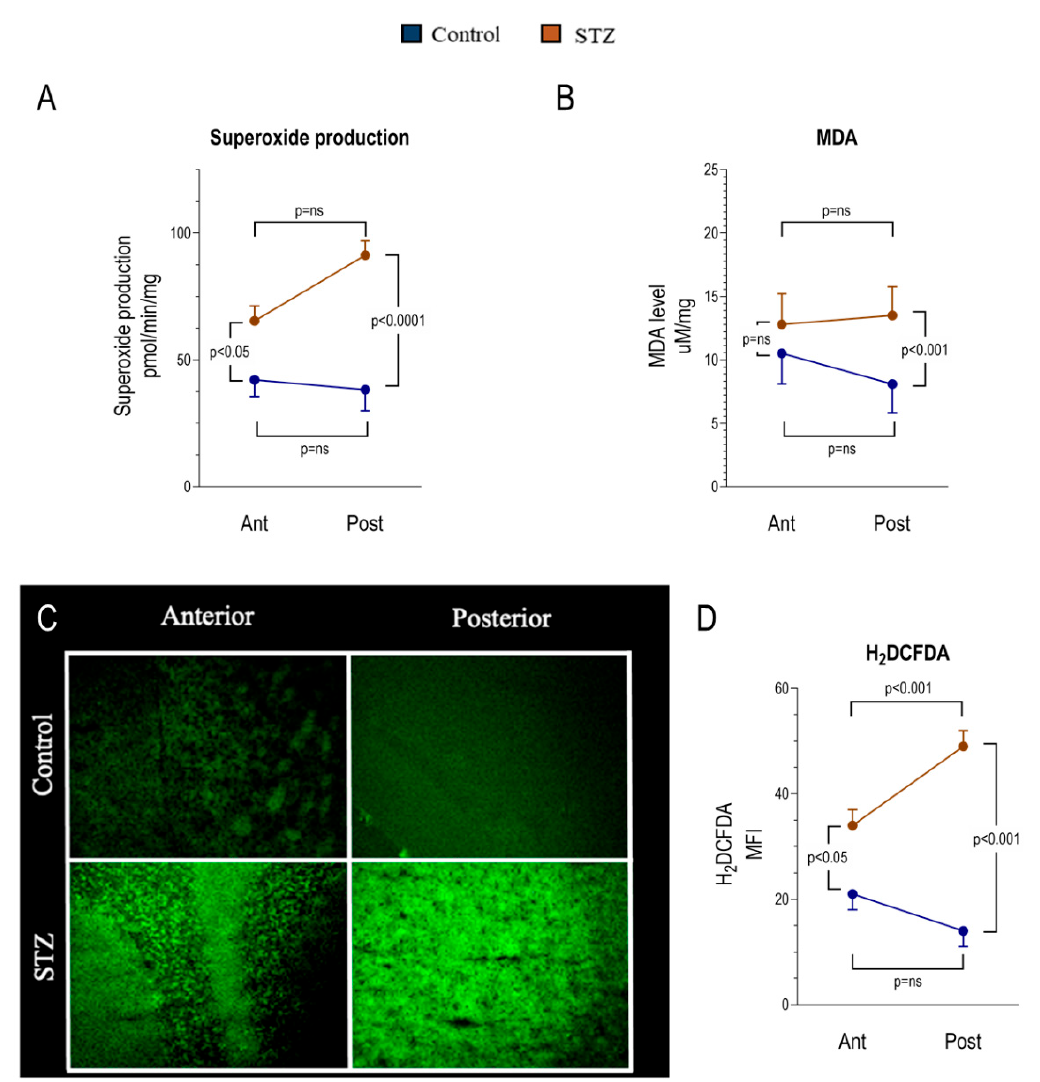
Figure 4. Hyperglycemia effect on oxidative state of anterior and posterior brain areas as assessed by spectrophotometry and cellular fluorescence. Panels A and B show the degree of superoxide production and malondialdehyde (MDA) content in the anterior (Ant) and posterior (Post) brain regions in control ( n = 6 for each area, blue) and STZ mice ( n = 6 for each area, brown). Panels C and D display representative images of anterior and posterior brain areas stained with 2 ′ ,7 ′ -dichlorofluorescein diacetate (H 2 DCFDA) to assess the presence of Reactive Oxygen Species (ROS) (Panel C ) and the corresponding mean fluorescence index (MFI) of H 2 DCFDA (Panel D ) in the same subgroups. Data are expressed as mean ± SD.